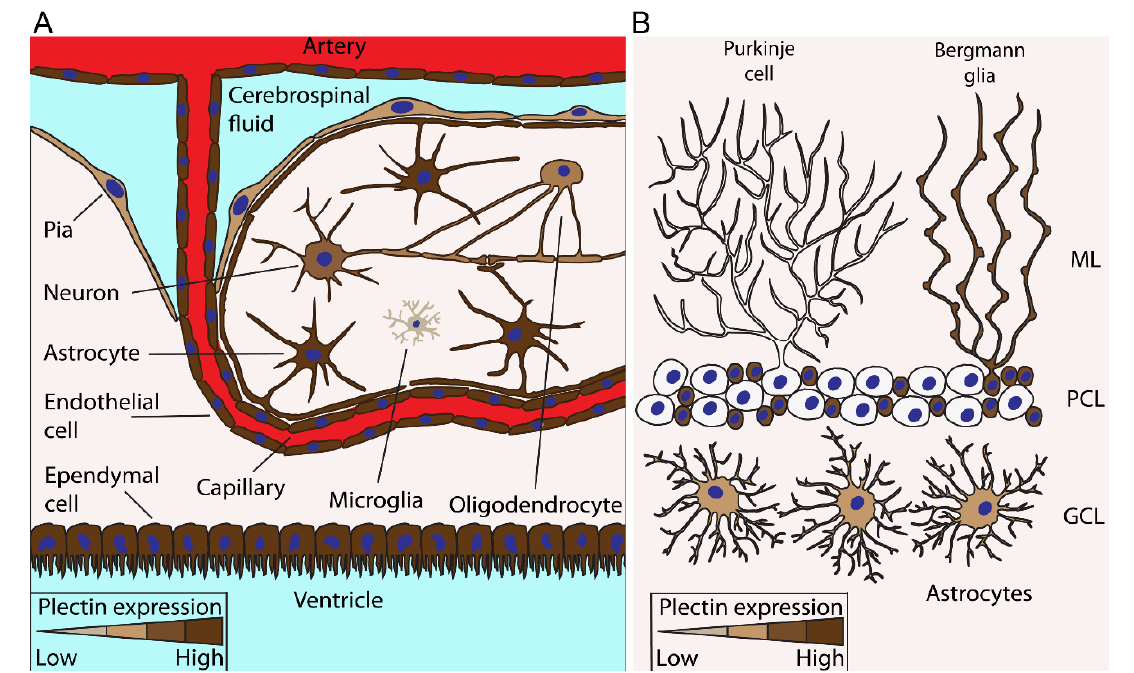
Figure 2. Expression of plectin in various cells types in the brain. The figure depicts plectin-expressing cells in the cerebrum ( A ) and cerebellum ( B ). ( A ), Particularly the abundant expression of plectin (dark brown) is a trait of cells such as astrocytes, endothelial cells, and ependymal cells at the boundaries between brain parenchyma and fluid-filled compartments; for example, arteries, capillaries, and ventricles. Besides cells at the border of the parenchyma and fluid-filled parts of the brain, neurons, oligodendrocytes, and intermittently microglia also express plectin. ( B ), In the cerebellum, Bergmann glia in the molecular layer (ML) and astrocytes in the granule cell layer (GCL) also express plectin; however, plectin was not detected in Purkinje cells from rat cerebellum [23] . The abundance of plectin expression in each particular cell type is denoted by the colour intensity, according to the colour scales at the bottom of each panel. PCL, Purkinje cell layer.